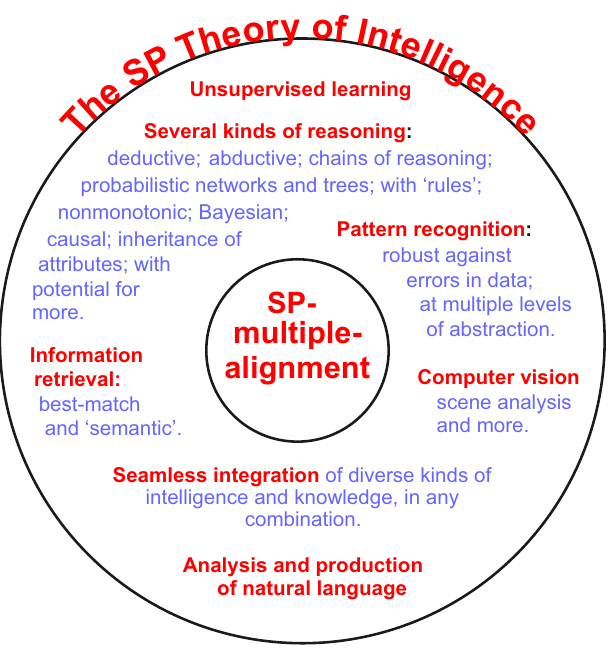
Figure A5. A schematic representation of versatility and seamless integration in the SPTI, with the SPMA concept centre